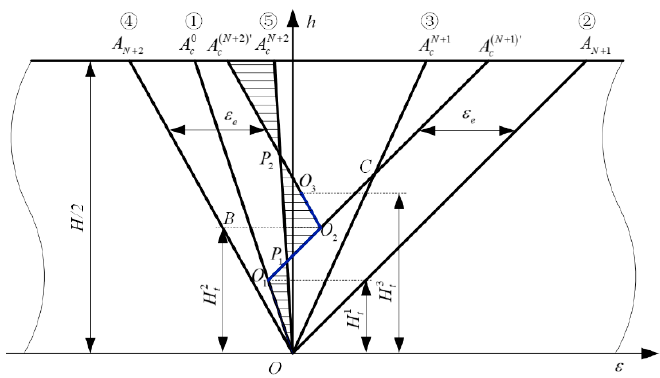
Figure 4. Evolution of residual stress in the second bending.